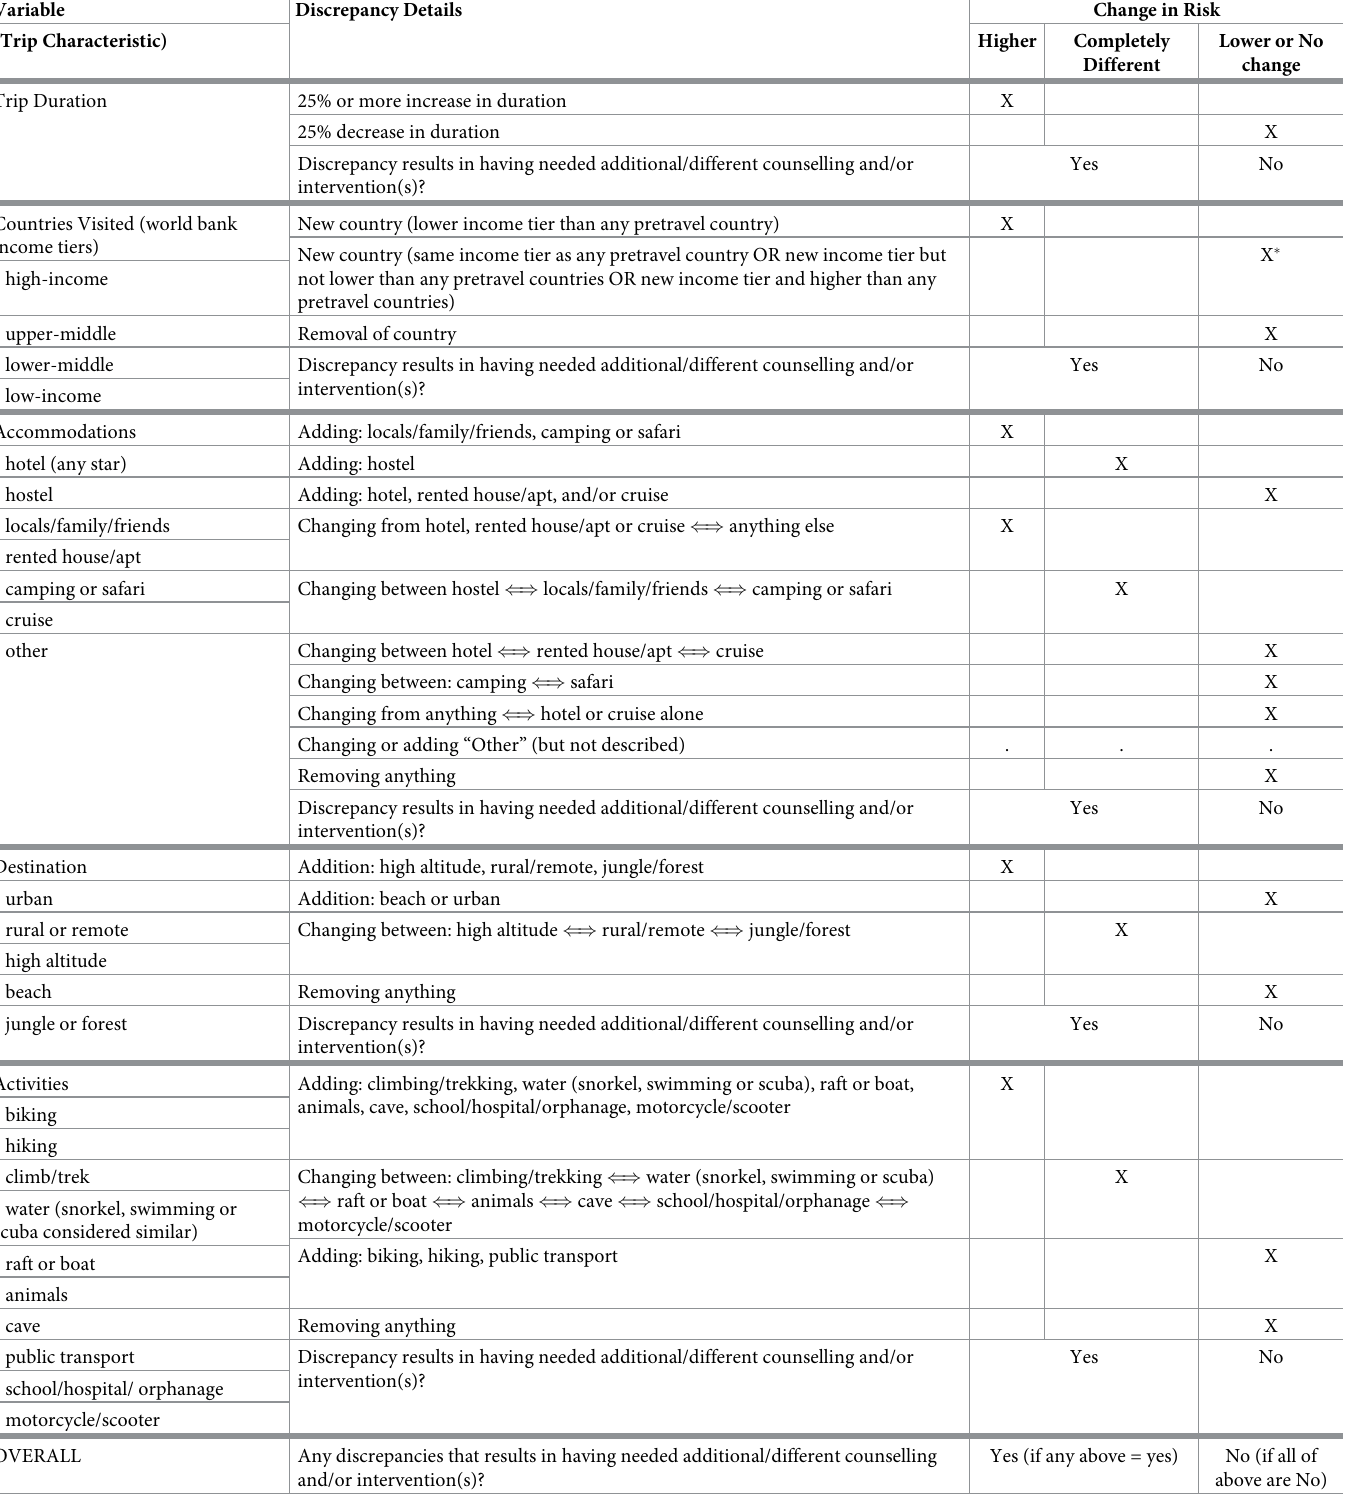
Table 1. Decision algorithm for categorizing discrepancies in trip